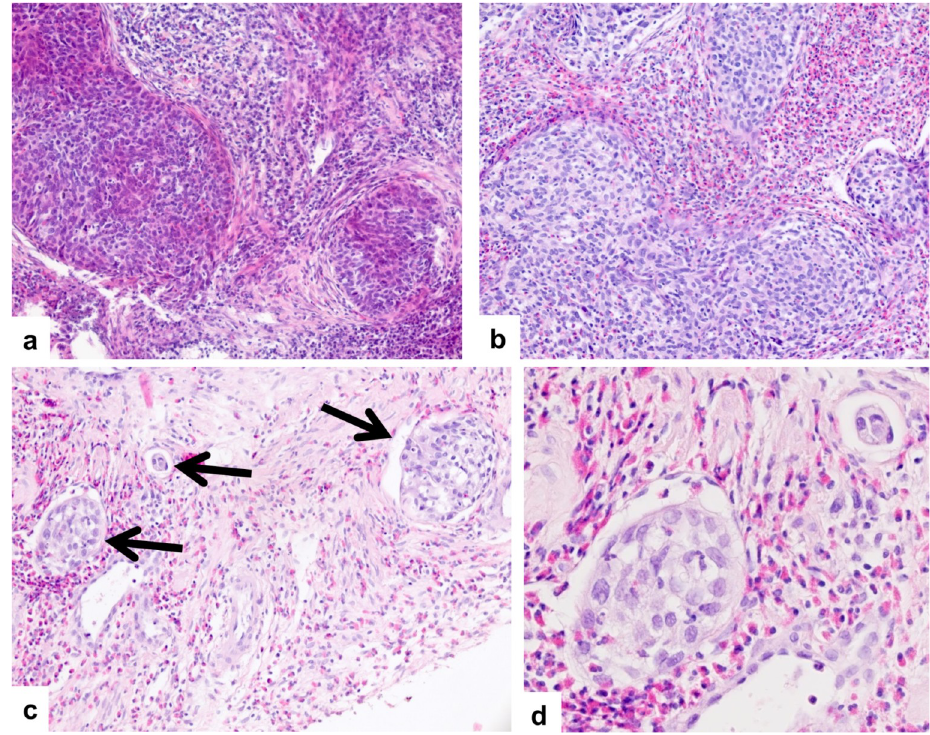
Fig 2. Peritumoral inflammation and lymphovascular space invasion. Squamous cell carcinoma with strong peritumoral inflammtory response with lymphocytic (a) and eosinophilic (b) predominance. Multiple lymphovascular involvement (arrows) is shown in (c). Intravascular tumor cell surrounded by lymphoepithelial cells in lymphovascular space invasion can be seen in (d).